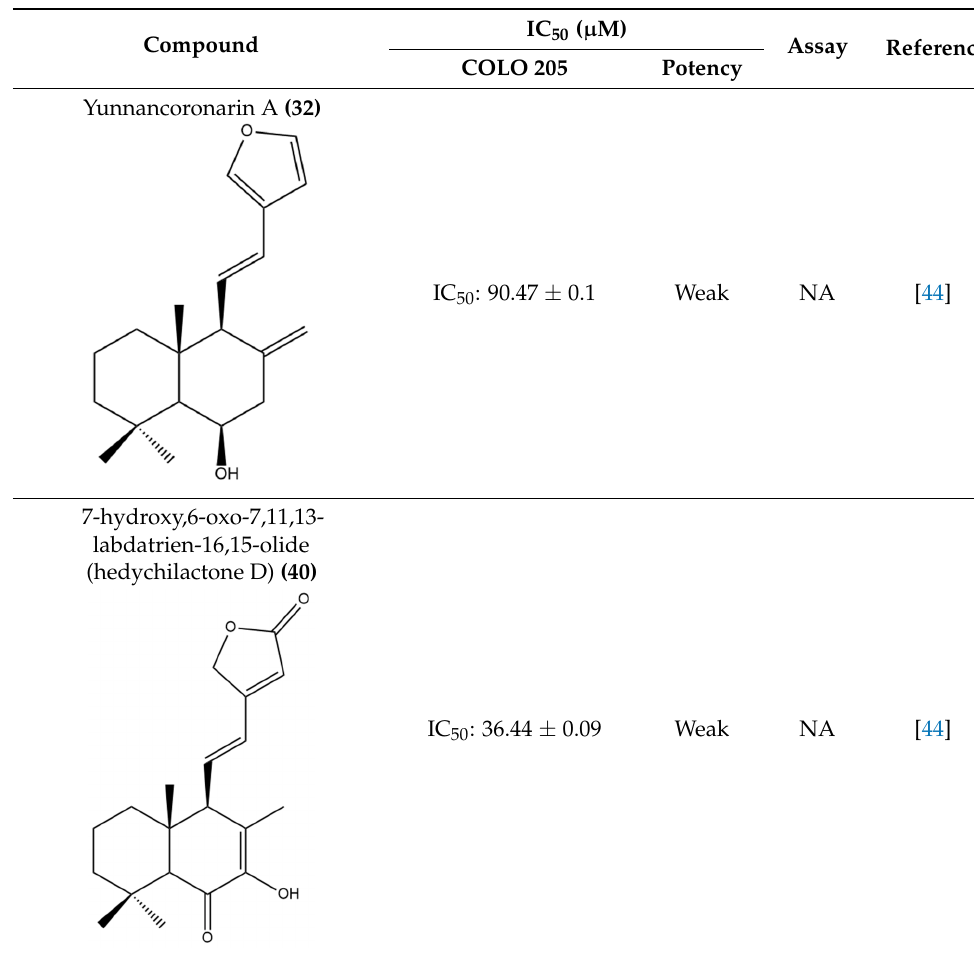
Table 15. Cytotoxic activities of labdane-type diterpenes from the Zingiberaceae against COLO 205 colorectal cancer cell line.